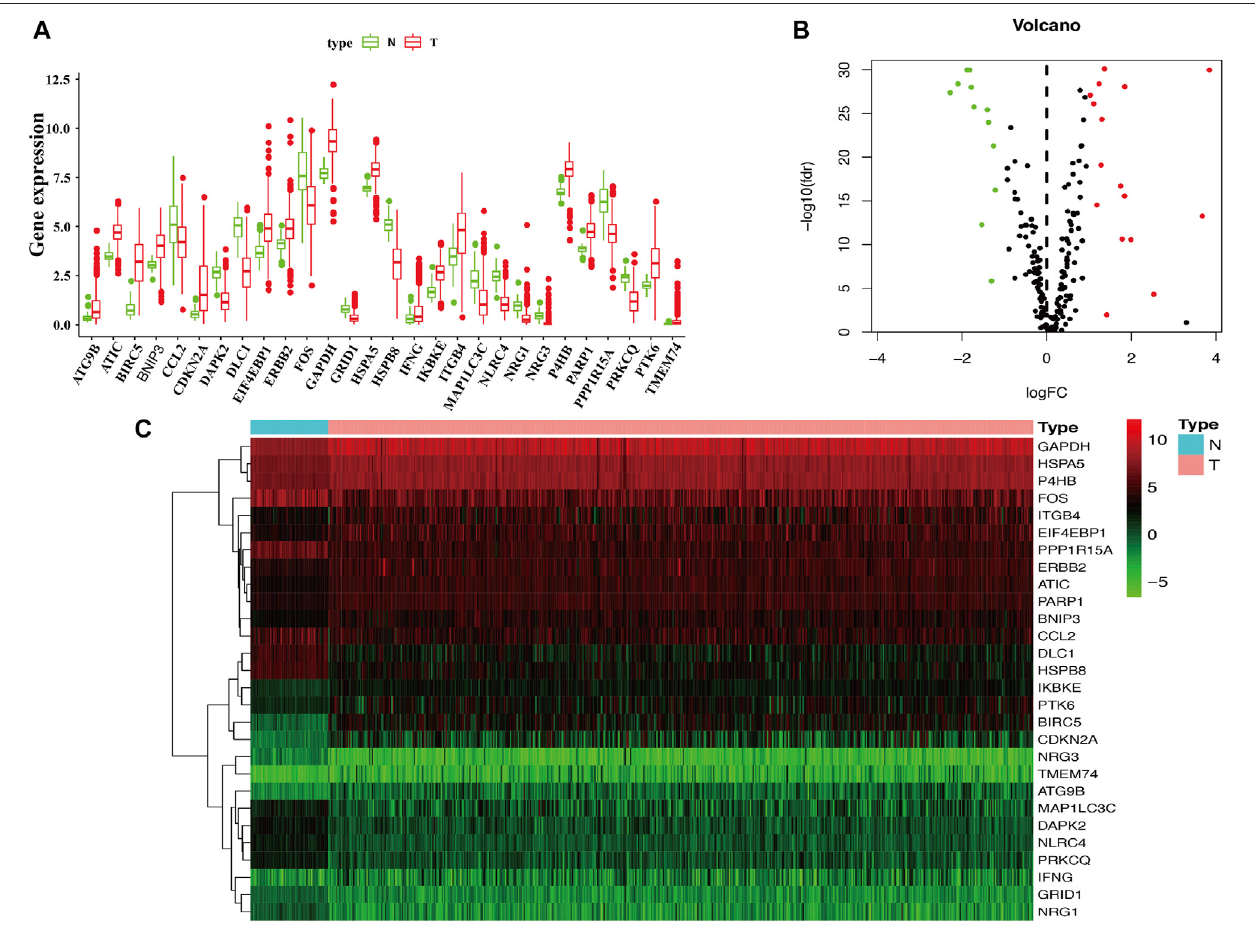
FIGURE2| Identi fi cation ofdifferentiallyexpressed ARGsinLUAD. (A) Theboxplotofthedifferentiallyexpressed ARGs.Theredcolorindicates tumortissues,and the green color indicated the non-tumor. (B) Volcano plot of the 222 ARGs analysis. There were 28 ARGs differentially expressed in LUAD, including 12 downregulated genes and 16 upregulated genes. X-axis: log 2-fold change; Y-axis: − log10 fdr for each probe. (C) Two-dimensional hierarchical clustering of the signi fi cant 28 differentially expressed ARGs in LUAD patients. LUAD, lung adenocarcinoma.